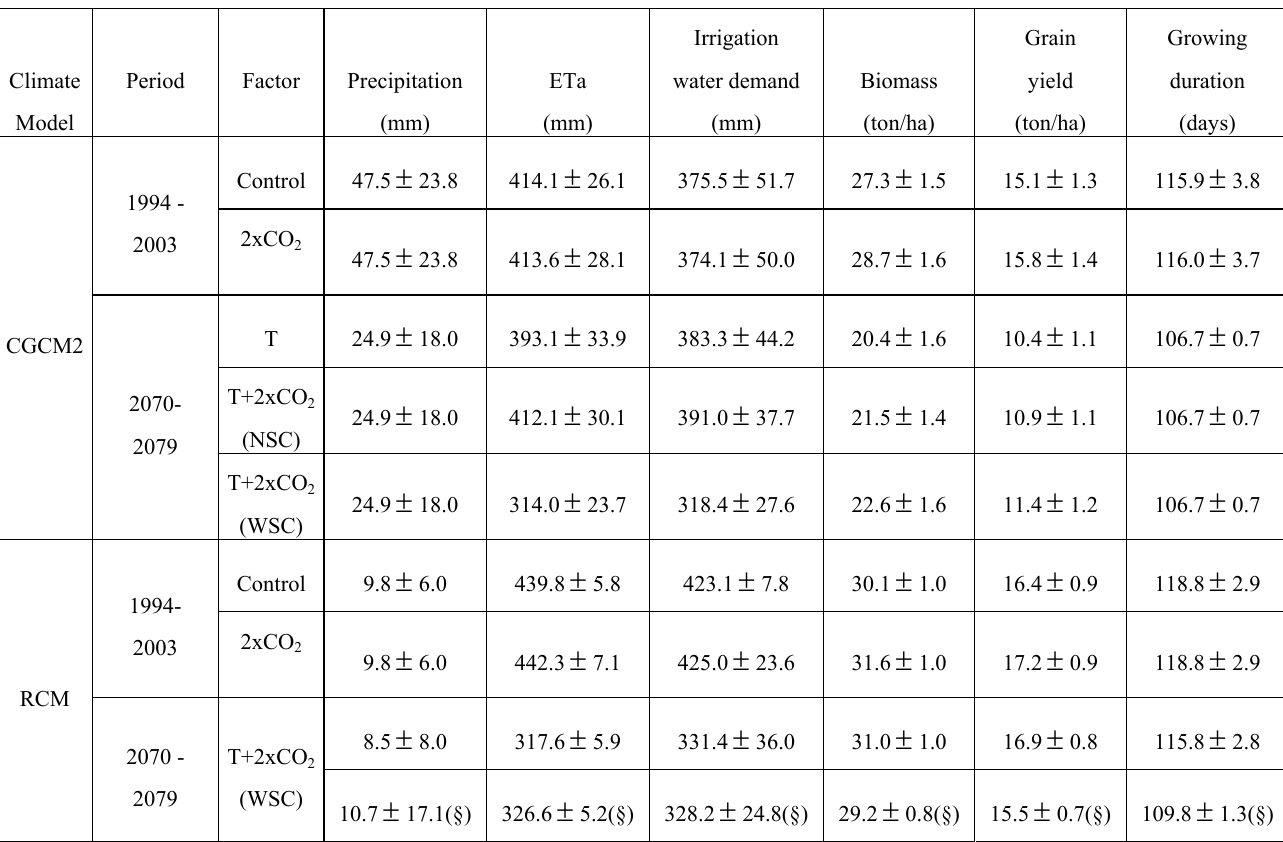
concentration (2xCO ) on water balance and crop growth for 2 2